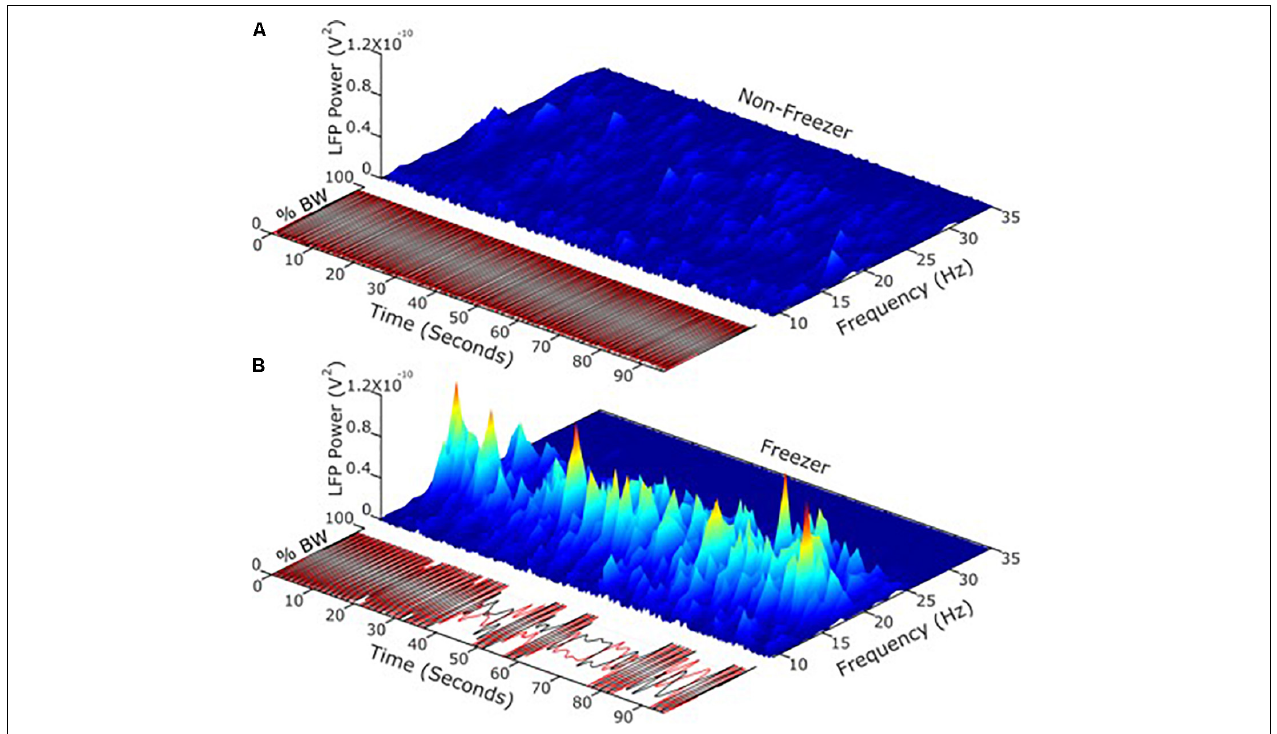
FIGURE 4 | (A) Using LFP’s and neurophysiology to define and address freezing of gait in Parkinson’s disease. (B) Temporal fluctuations and the extent of changeable behavior of STN band neural activity during movement differentiated PD freezers from